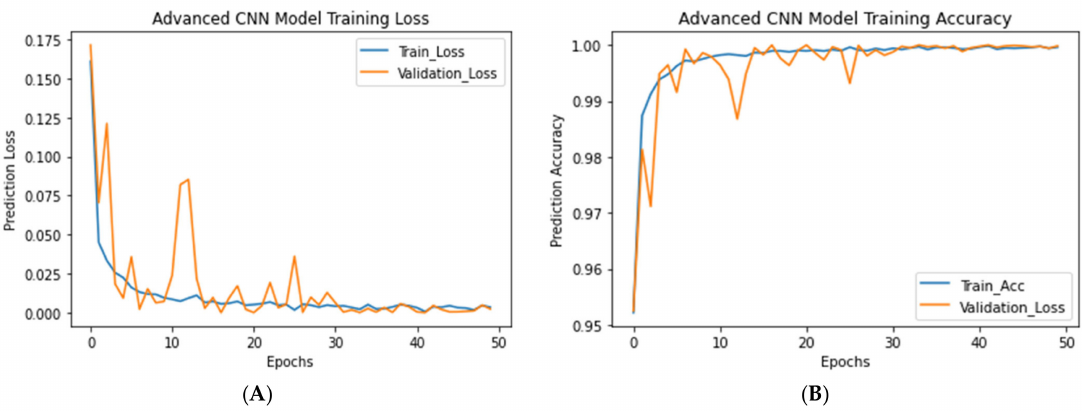
Figure 8. Advanced CNN model applied to new data. ( A ). Prediction losses as a function of epochs. ( B ). Prediction accuracy as a function of